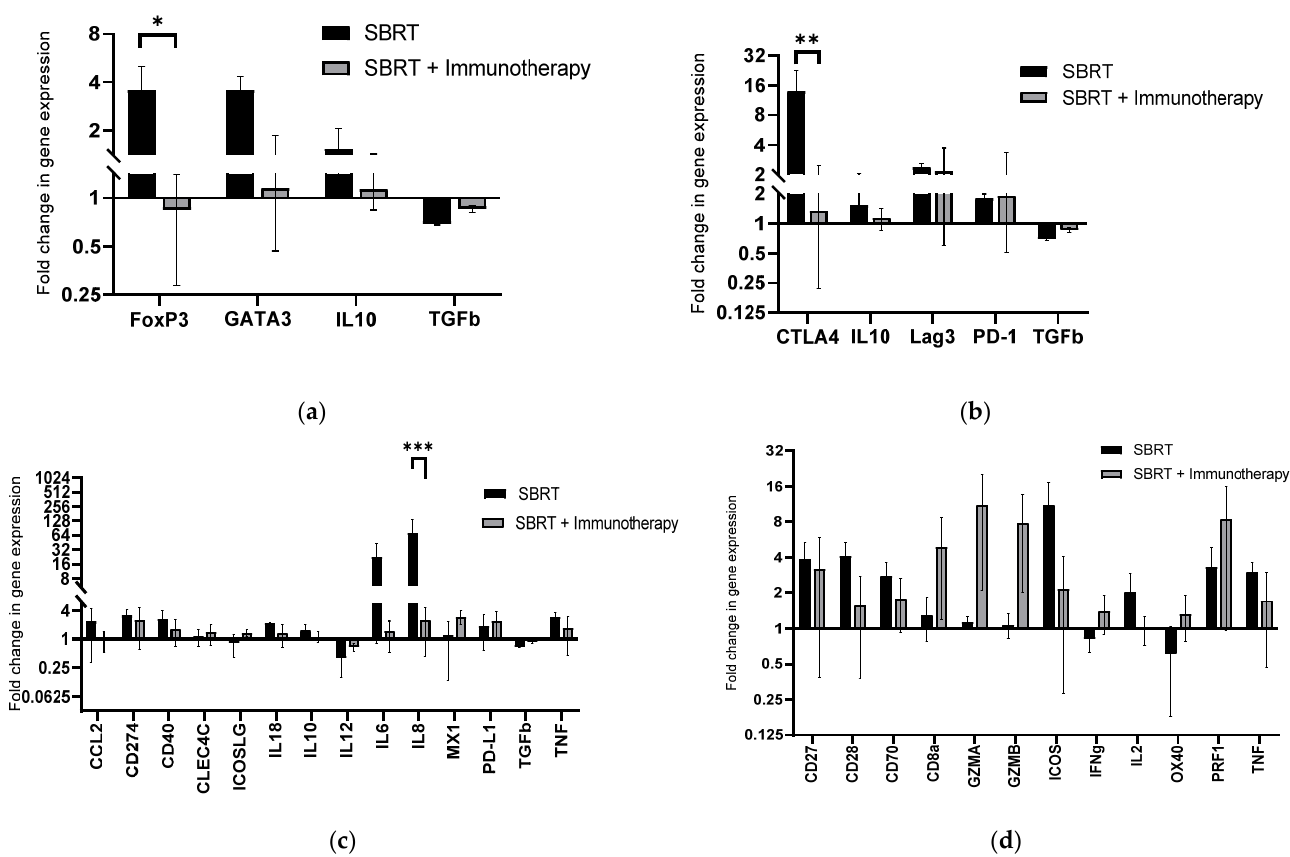
Figure 3. Tumor immune gene expression associated with SBRT and SBRT + immunotherapy: Fold change in post-treatment relative to pre-treatment gene expression counts for tumors treated with SBRT or SBRT and immunotherapy via custom canine Nanostring immune panel. Gene expression profiles were divided into patterns associated with ( a ) regulatory T cell gene expression; ( b ) exhausted T cell gene expression; ( c ) myeloid cell gene expression; ( d ) effector T cell gene expression. * p = 0.038, ** p = 0.005, *** p = 0.0001 (SBRT: n = 2, SBRT + immunotherapy: n = 3).